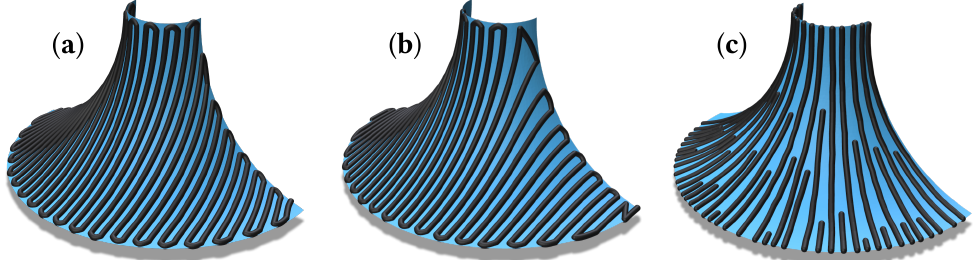
Figure 2. Direction parallel algorithms and resulting paths. Travel motions are not displayed. With d = 1 mm ( a ) FInA, ( b ) FExA, ( c ) Ortheo. Filament thickness displayed does not correspond to thickness when